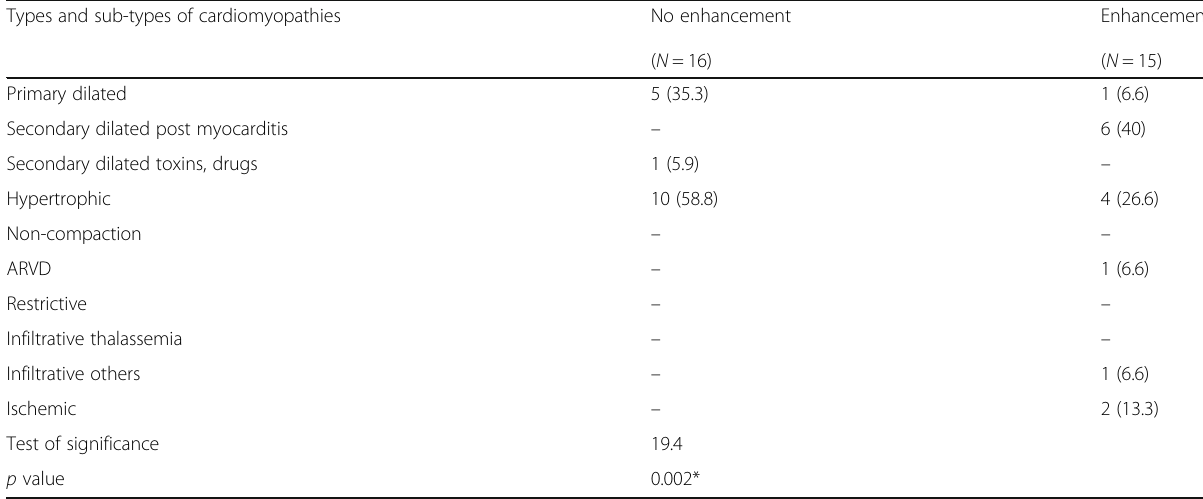
Table 3 LGE result in study groups (after exclusion of non-contrast study) Types and sub-types of